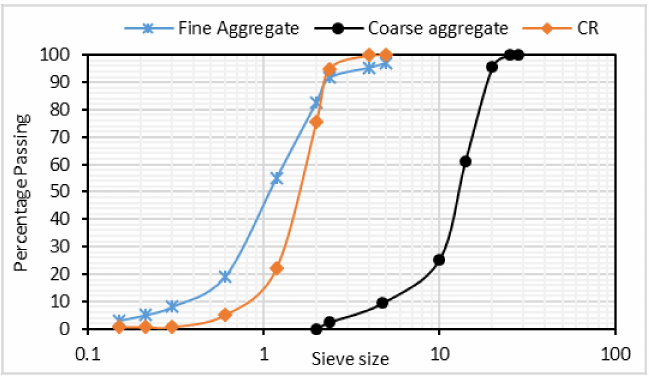
Figure 1. Particle Size distribution curves for Aggregates and CR used.